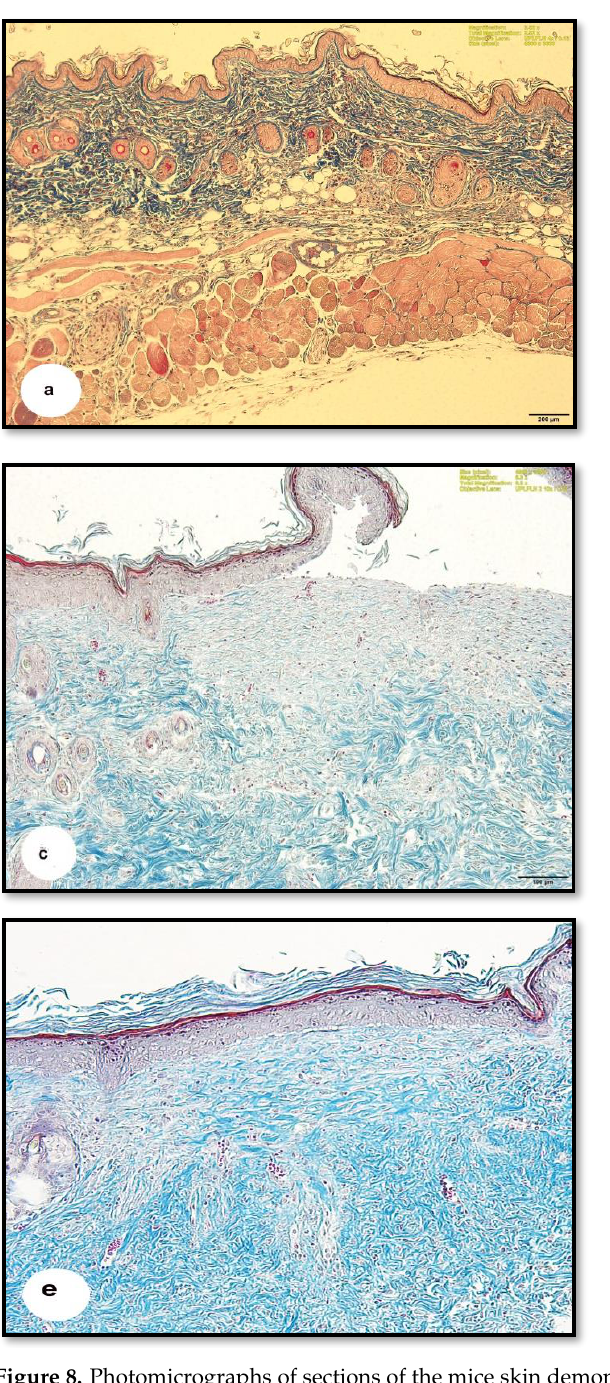
Figure 8. Photomicrographs of sections of the mice skin demonstrating the collagen fibers with blue color. ( a ) Showing the normal skin with thick and plenty of collagen fibers in the dermal region, ( b ) showing the burnt skin with thinner and fewer fibers, ( c ) showing the burnt skin treated with cold cream with moderate expression of the blue collagen fibers, ( d ) showing the burnt skin treated with 1% silver sulphadiazine demonstrating pale collagen fibers in the hypodermal region, and ( e ) showing the burnt skin treated with 1% silver sulphadiazine and protease enzyme revealing dens highly and darkly stained collagen fibers in the hypodermal region. (Masson trichrome, scale bars: a = 100 µ m, b = 100 µ m, c = 100 µ m, d = 100 µ m, e: Magnification: 6.3×) .